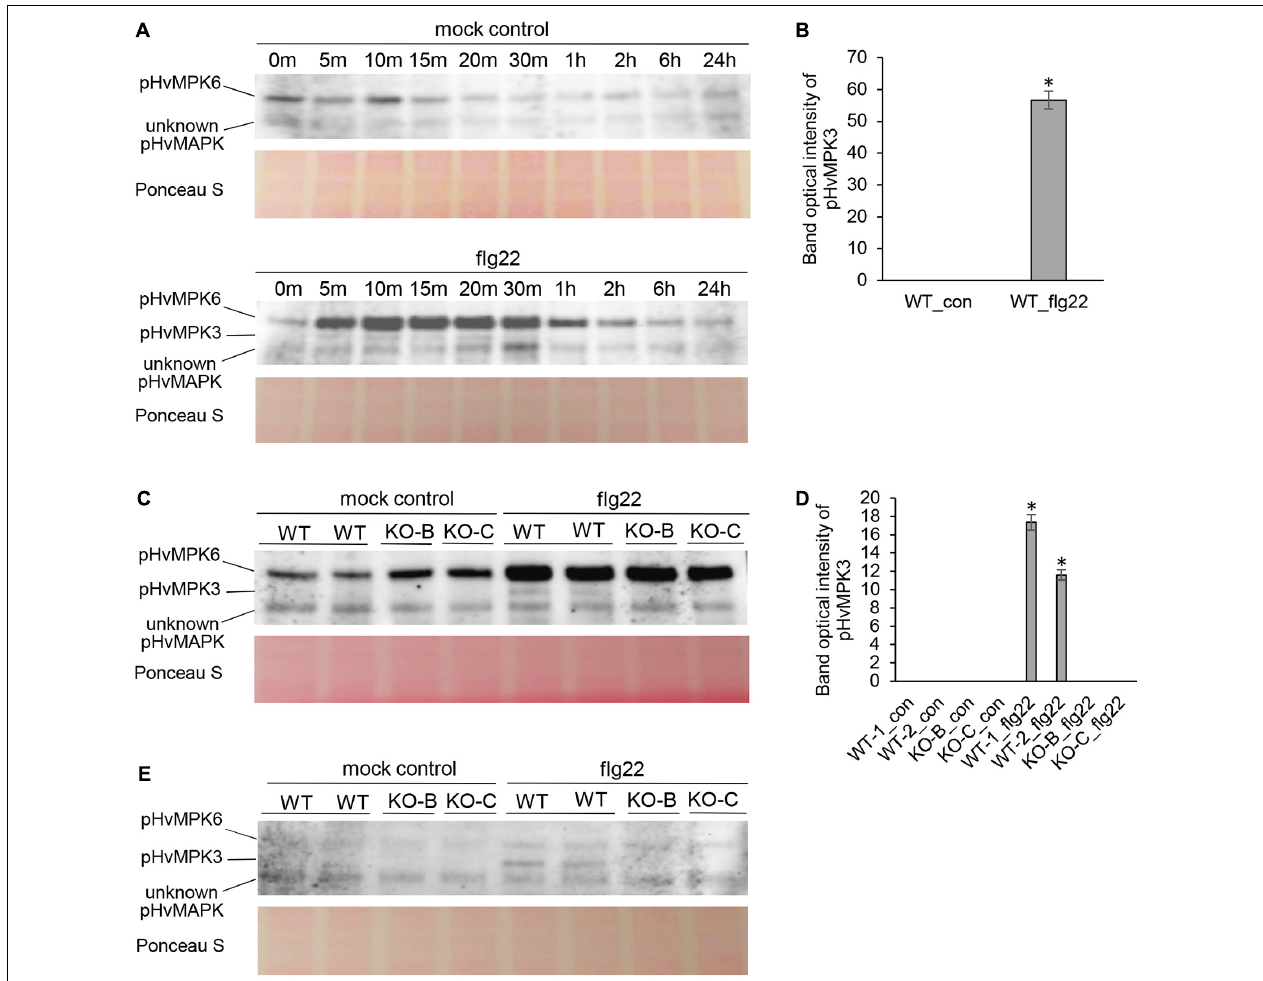
FIGURE 2 | Activation of barley pHvMPK6, pHvMPK3 and unknown pHvMPK in roots of wild type (WT) and HvMPK3 KO lines (KO-B and KO-C) after flg22 treatment detected by immunoblotting analyses. (A) Time course activation of barley MAPKs in flg22-treated roots of WT seedlings as detected using polyclonal anti-pERK antibody. (B) Quantification of band intensities in (A) after 15 min of treatment. Asterisks indicate statistically significant differences between flg22-treated and mock-treated WT at p < 0.05 (Student’s t -test). (C) Activation of MAPKs in roots of WT and HvMPK3 KO lines after 15 min long flg22 treatment, as detected by polyclonal anti-pERK antibody. (D) Quantification of band intensities in (C) . Asterisks indicate statistically significant differences between flg22-treated WT and HvMPK3 KO lines at p < 0.05 (Student’s t -test). (E) Activation of MAPKs in roots of WT and HvMPK3 KO lines after 15 min long flg22 treatment, as detected by monoclonal anti-pERK antibody. Uncropped, full original images of the whole immunoblots are provided in Supplementary Figures 6, 7